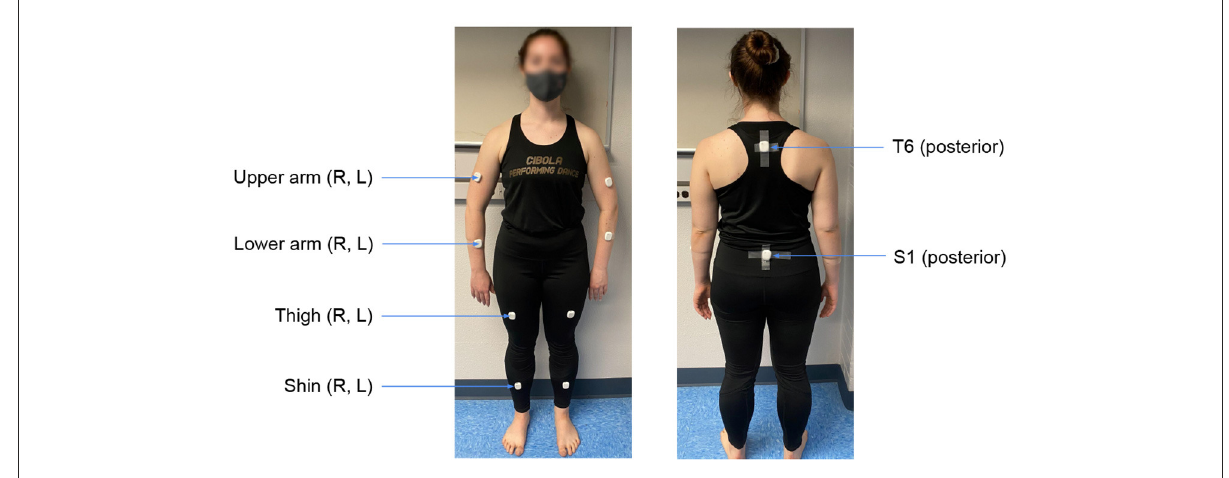
FIGURE3 Ten anatomical locations used for sensor attachment. Sensors are attached on clothes just for demonstration